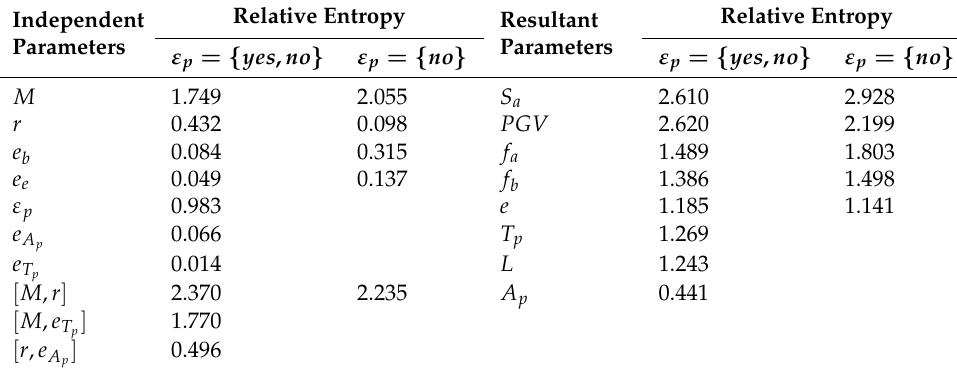
Table 3. Probabilistic sensitivity analysis results for ground motion with probabilistic pulse and no pulse for cross-braced